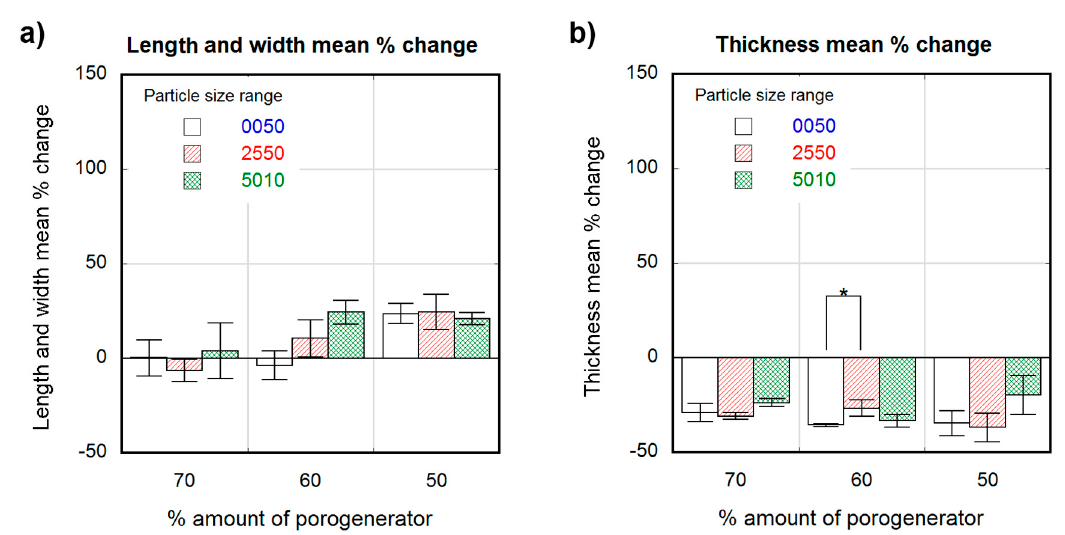
Figure 4 . Dimensional variation in percentagevalues for dry scaffolds obtained from different particle sizes (white 0–50-µm, stripe pattern 25–50-µm, cross pattern 50–100-µm) and proportions as a function of the theoretical percental amount of porogenerator: scaffold length and width mean % change ( a ); scaffold thickness mean % change ( b ). Significance level according to the Student t -test * p < 0.05.